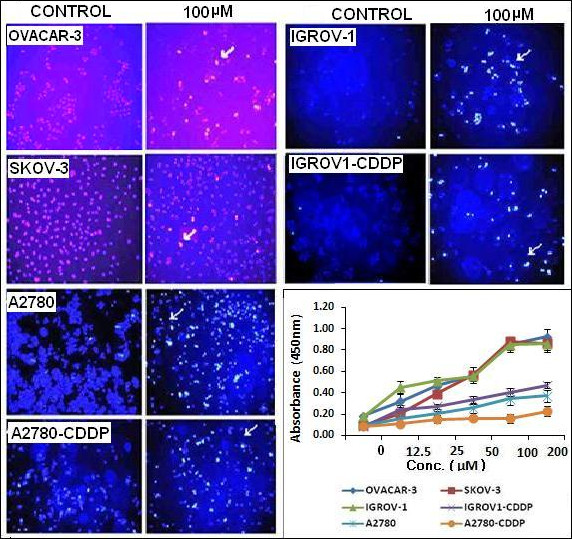
Hoechst staining of cell to detect BT induced apoptosis. Ovarian cancer cell lines were treated with 100 μM BT for 24 hrs. Treated/untreated cells were stained with Hoechst 33258 and visualized by fluorescence microscopy. Representative images were taken with an inverted microscope (Olympus H4-100, CCD camera) and 20× objective. Graph: Quantification of percent of apoptosis in terms of DNA fragmentation using Trevigen’s TACS® 2 TdT in Situ Apoptosis Detection Kit (TUNEL assay). Cells were treated with BT as explained earlier. At the end of the treatment time, labelled nucleotides were added and detected with HRP – HRP substrate (TACS-Sapphire) system. The absorbance was measured at 450 nm using a microplate reader, Multiskan (Thermo Scientifics). Experiments were performed in duplicate. Data was expressed as mean ± SD of duplicate experiments.